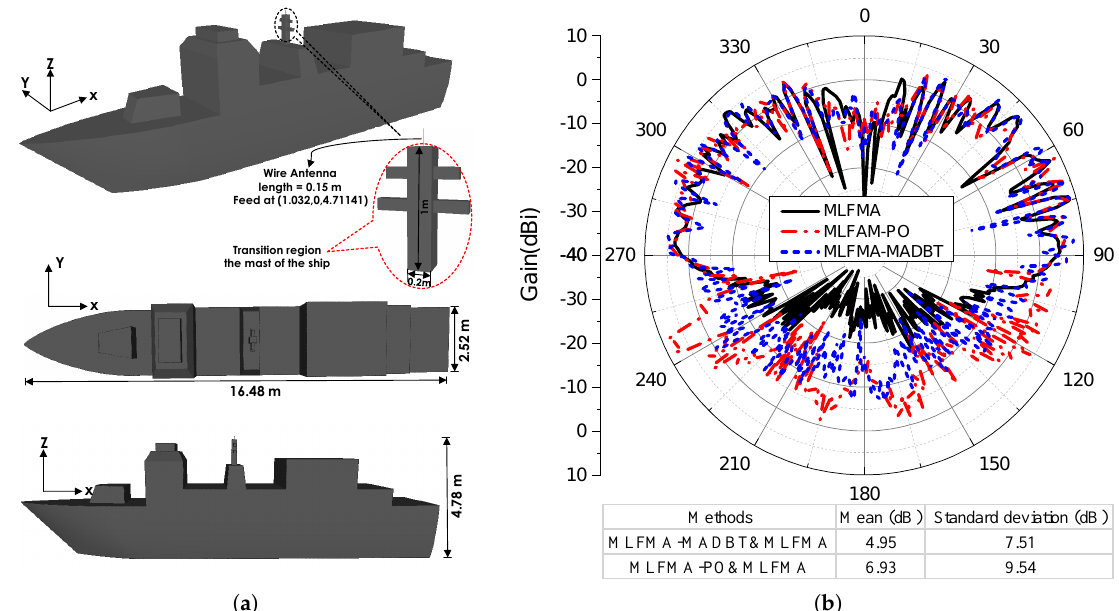
Figure 11. The model and far-field radiation patterns in XOZ plane of the wire antenna mounted on a realistic ship. ( a ) Model ( b ) Comparison result.